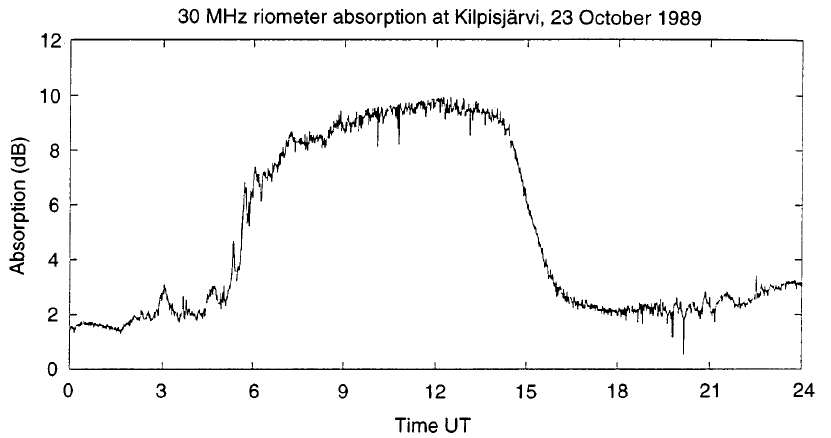
Fig. 1. Riometer absorption at 30 MHz measured at Kilpisja¨ rvi during the PCA